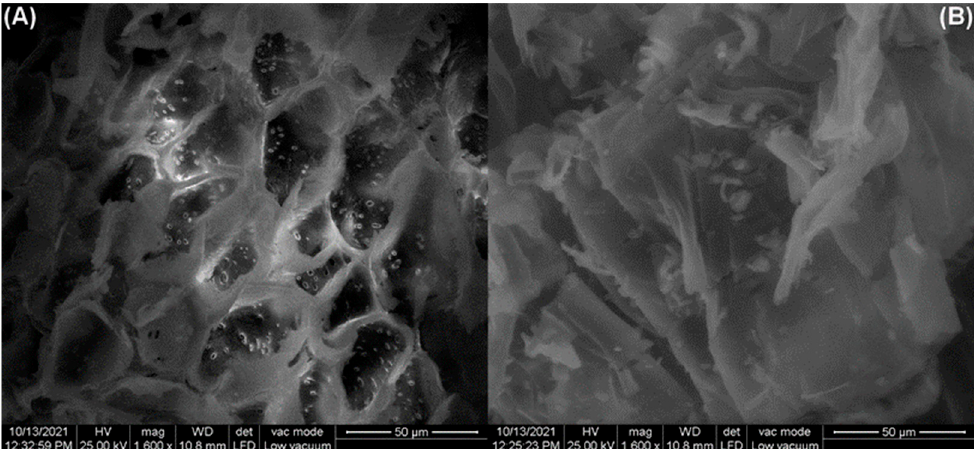
Figure 3. SEM images of adsorbent obtained from motherwort ( Leonurus cardiaca L.) biomass before adsorption ( A ) and after adsorption ( B ). adsorption ( A ) and after adsorption ( B